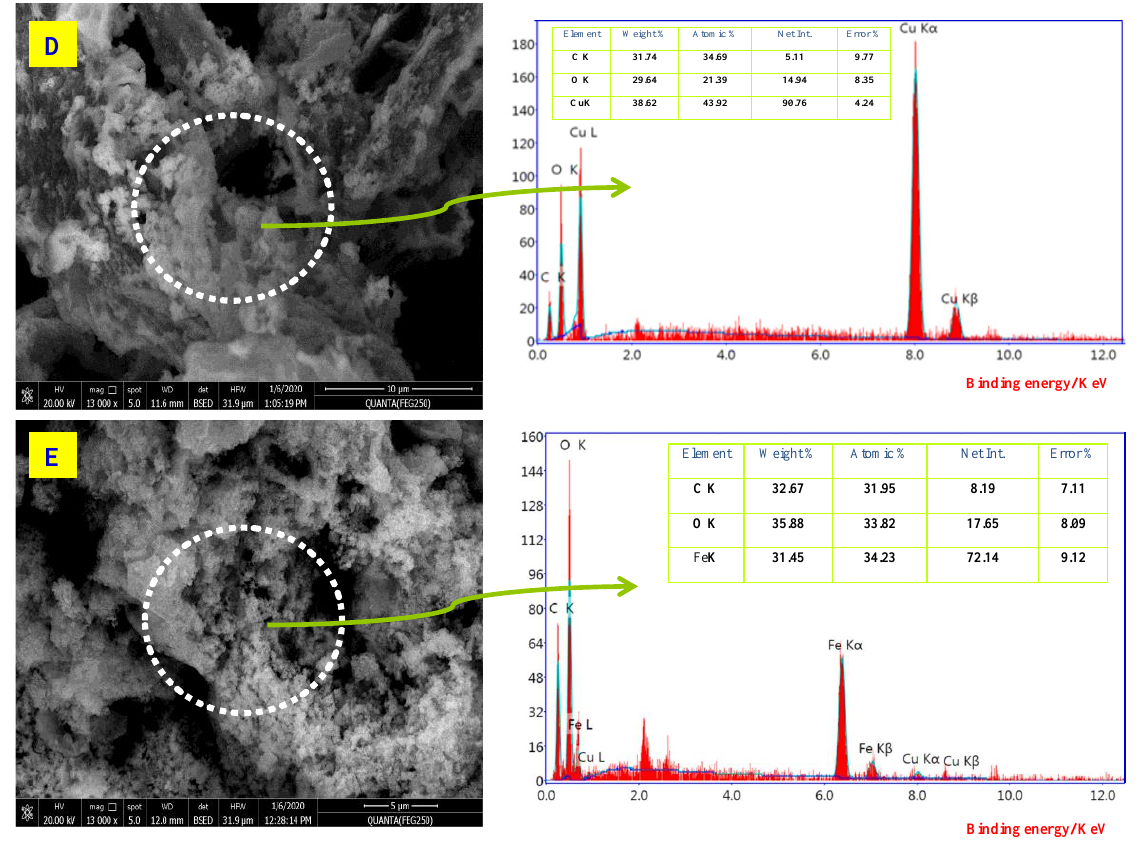
Figure 3. Field-emission scanning electron microscopy (FE-SEM) and energy-dispersive X-ray spectroscopy (EDX) spectra of ( A ) cellulose, ( B ) PAC, ( C ) PAC/NiONPs, ( D ) PAC/CuONPs and ( E ) PAC/Fe 3 O 4 NPs nanocomposites.